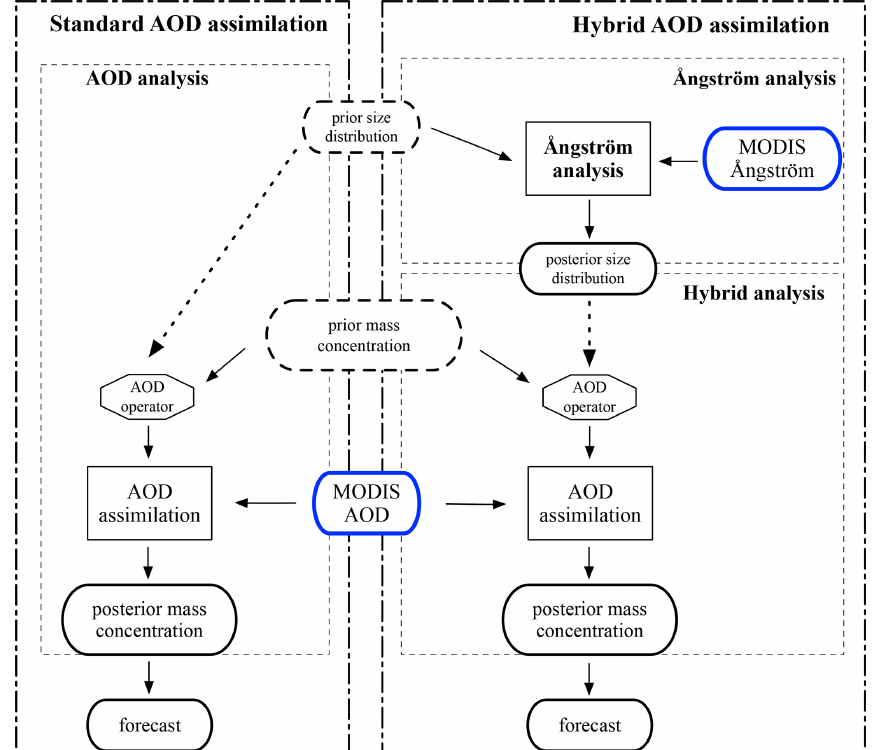
Figure 6. Standard and hybrid AOD data assimilation